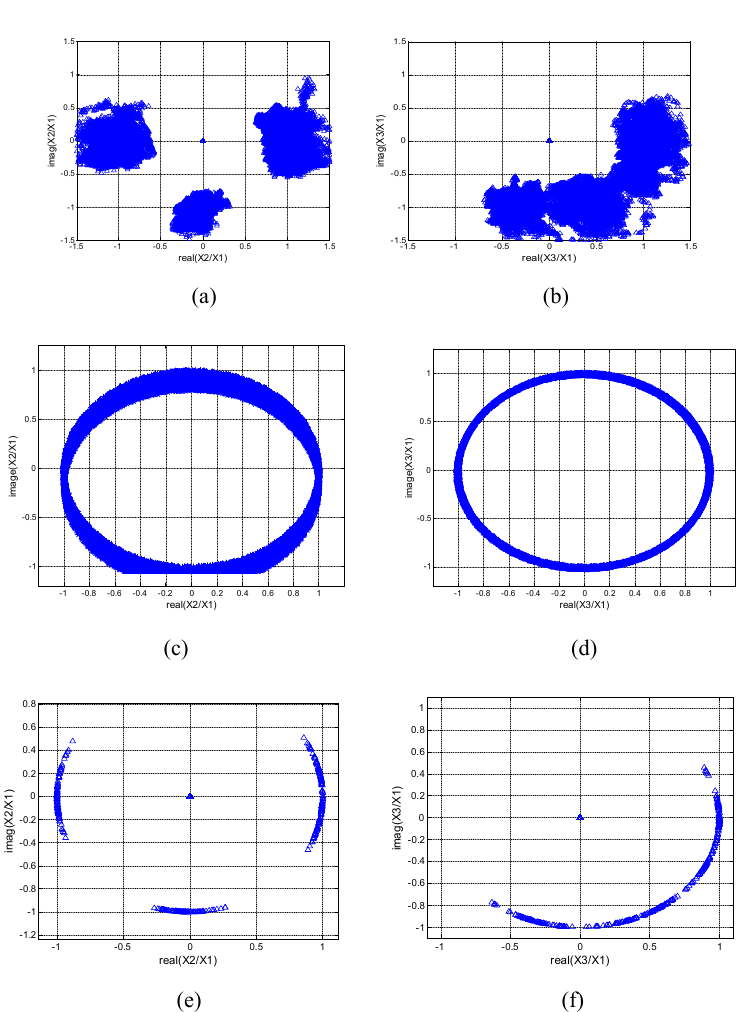
Fig. 2. Time-frequency point ratio hash map under different processing